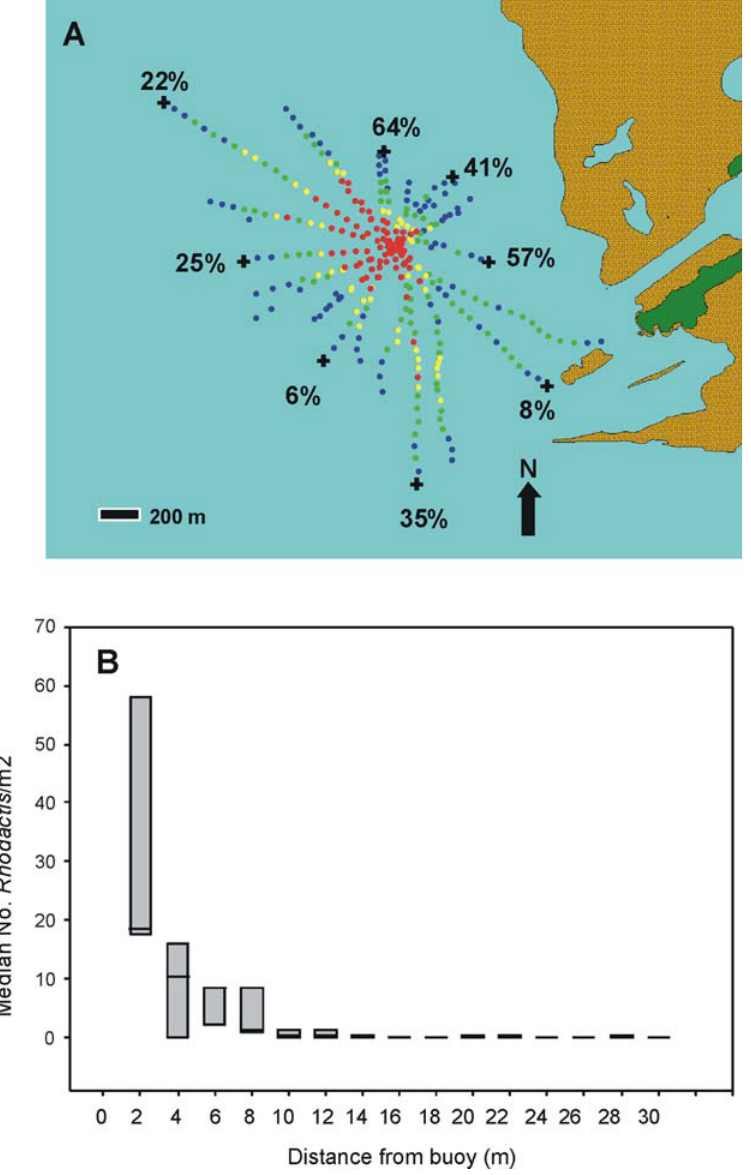
Figure 2. Details of corallimorph invasion near man-made objects. A) Extent of corallimorph infestation on western shelf of Palmyra Atoll NWR (close-up of Fig. 1C). Color codes correspond to estimated benthic cover of corallimorphs: red=high ( . 60%), yellow=medium ( . 30–60%), green=light (1–30%), blue=no visible corallimorphs. The ship is at the center of the red zone. Estimated percentage of coral cover at limits of corallimorph infestation. B) Box plot (5 and 95 percentile, median) of numbers of Rhodactis /m 2 at 2 m intervals from 3 mooring buoys.